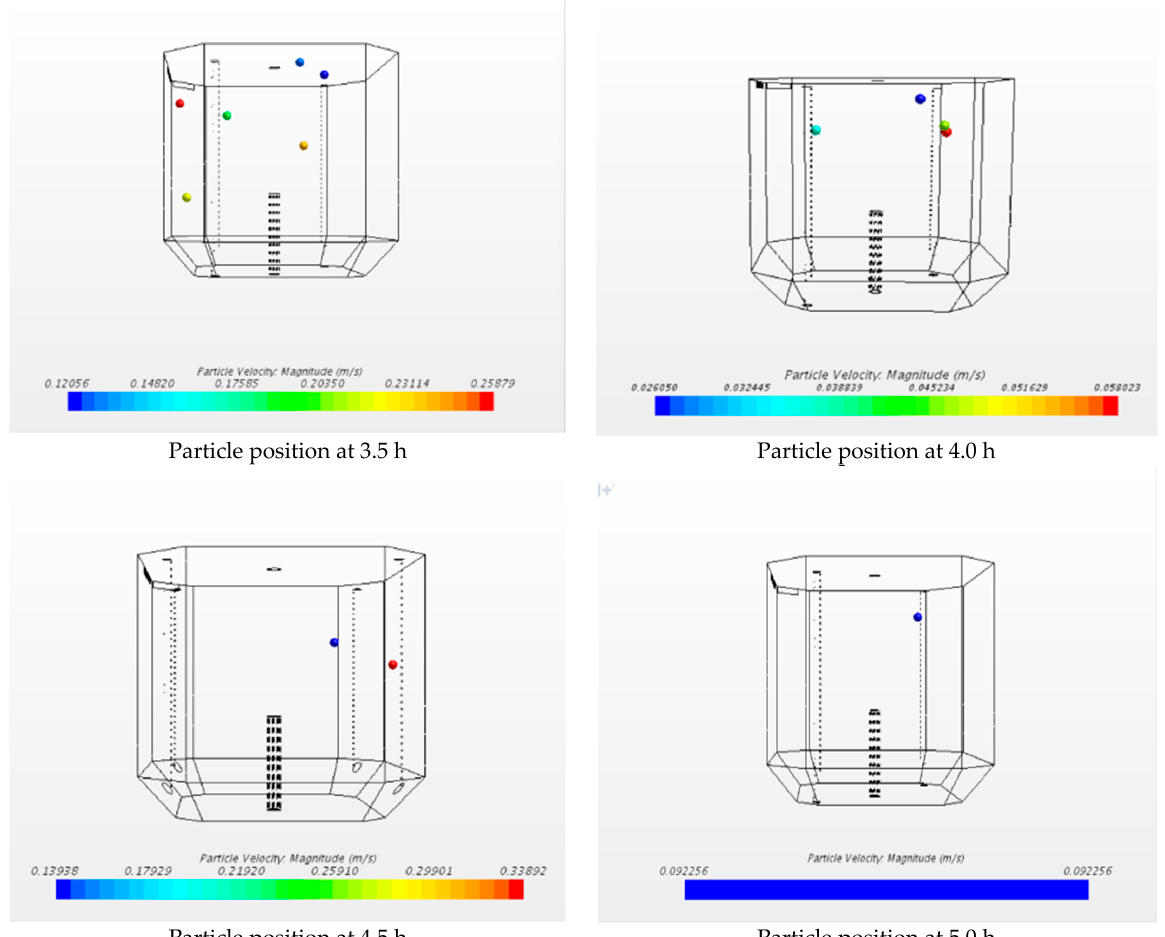
Figure 7. Particle position diagram in 0–5 h cabin. (2) Bottom outflow ratio of 30%